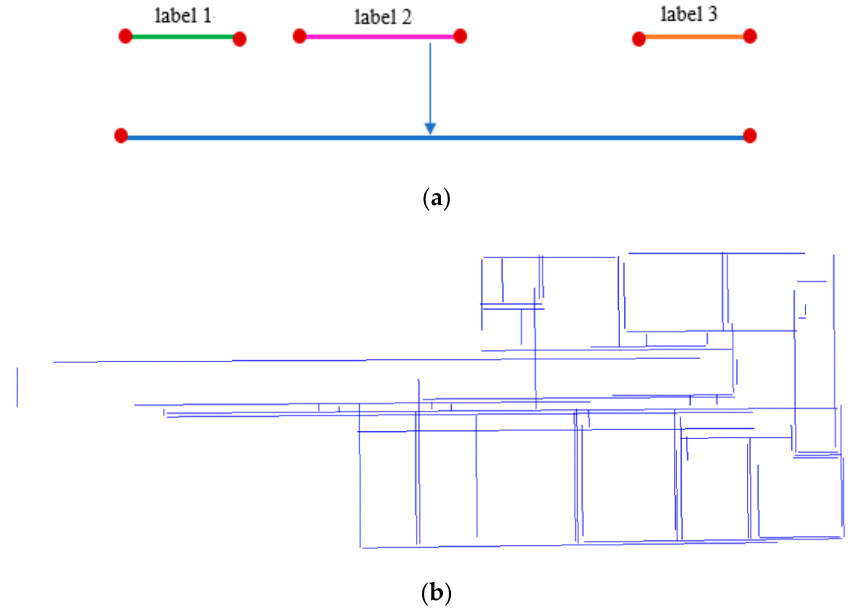
Figure 9. Clustering similar lines. ( a ) The line groups project onto the cluster line. ( b ) The final main lines.